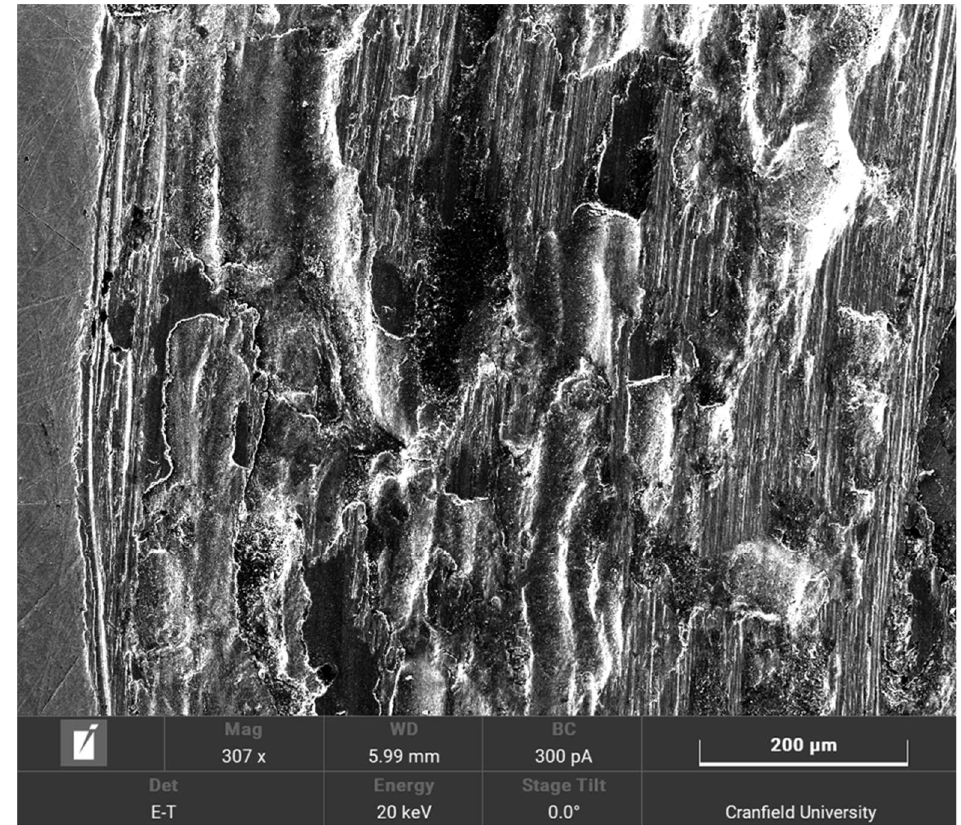
Figure 10. SEM image of the steel sample.